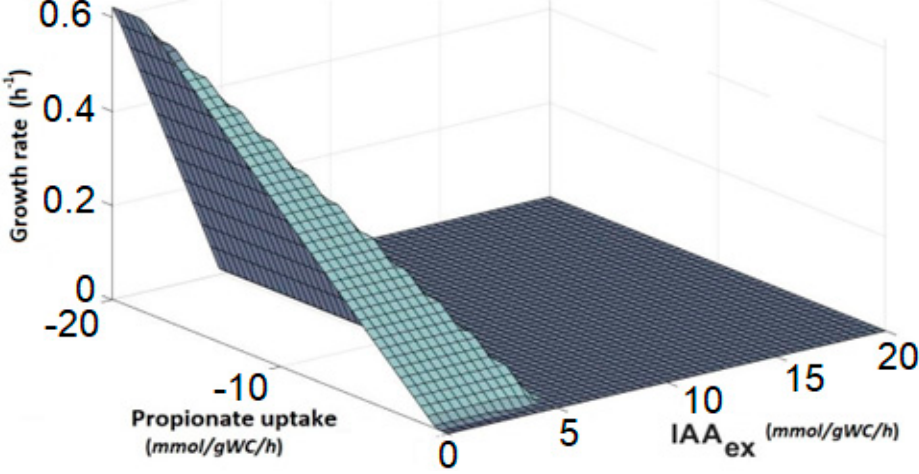
Figure 8. Phenotype Phase Plane analysis of propionate metabolism as a function of biomass and IAA production.